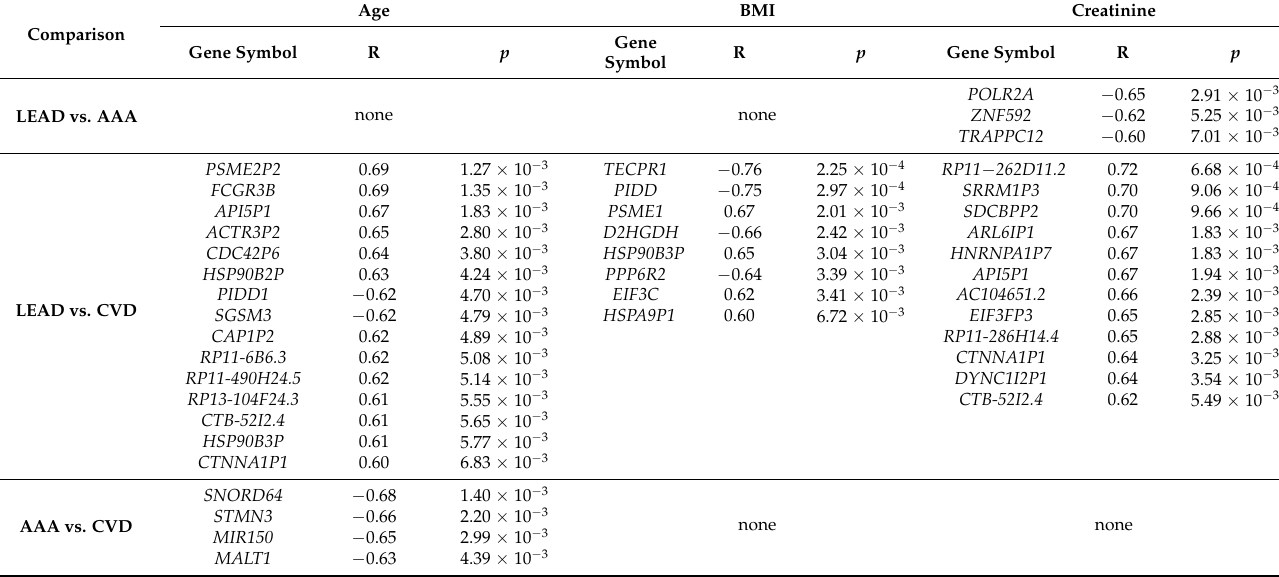
Table 3. Correlation analysis between characteristics of studied groups (age, BMI, creatinine level) and expression of 21, 58 and 10 genes identified as unique for LEAD vs. AAA, LEAD vs. CVD and AAA vs. CVD comparisons, respectively.